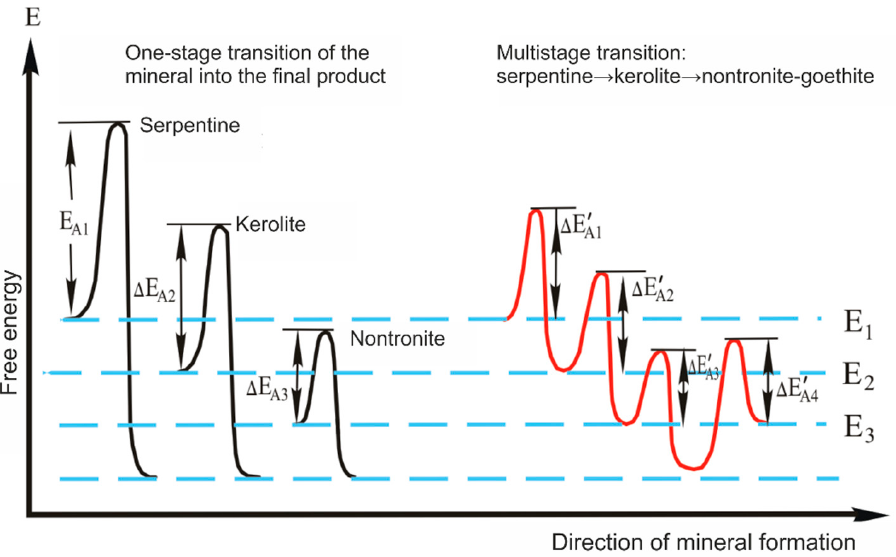
Figure 9. Diagram of changes in the free energy of the system during the transformation of hypergenic minerals in weathering crusts (Ostwald’s rule).